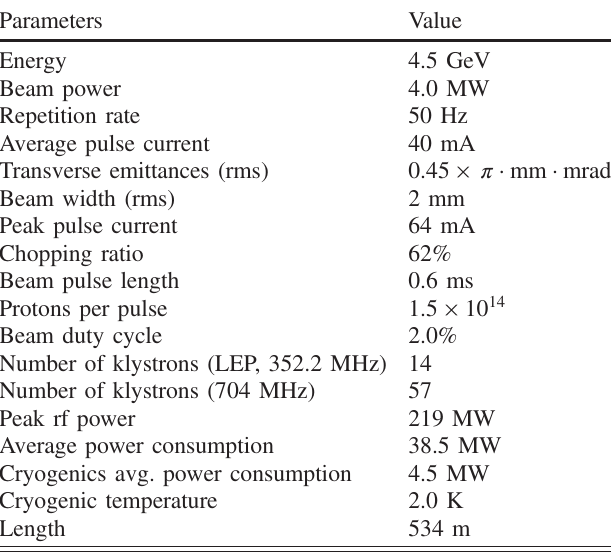
TABLE I. Parameters of the HP-SPL [2].